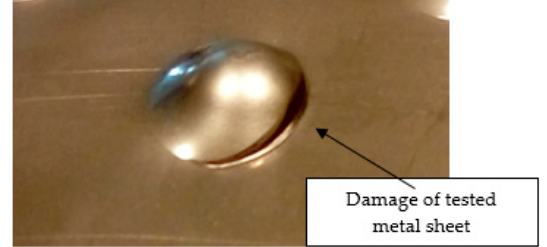
Figure 7. Tested metal sheet damage after the impact of 2 kg weight from 0.9 m height.